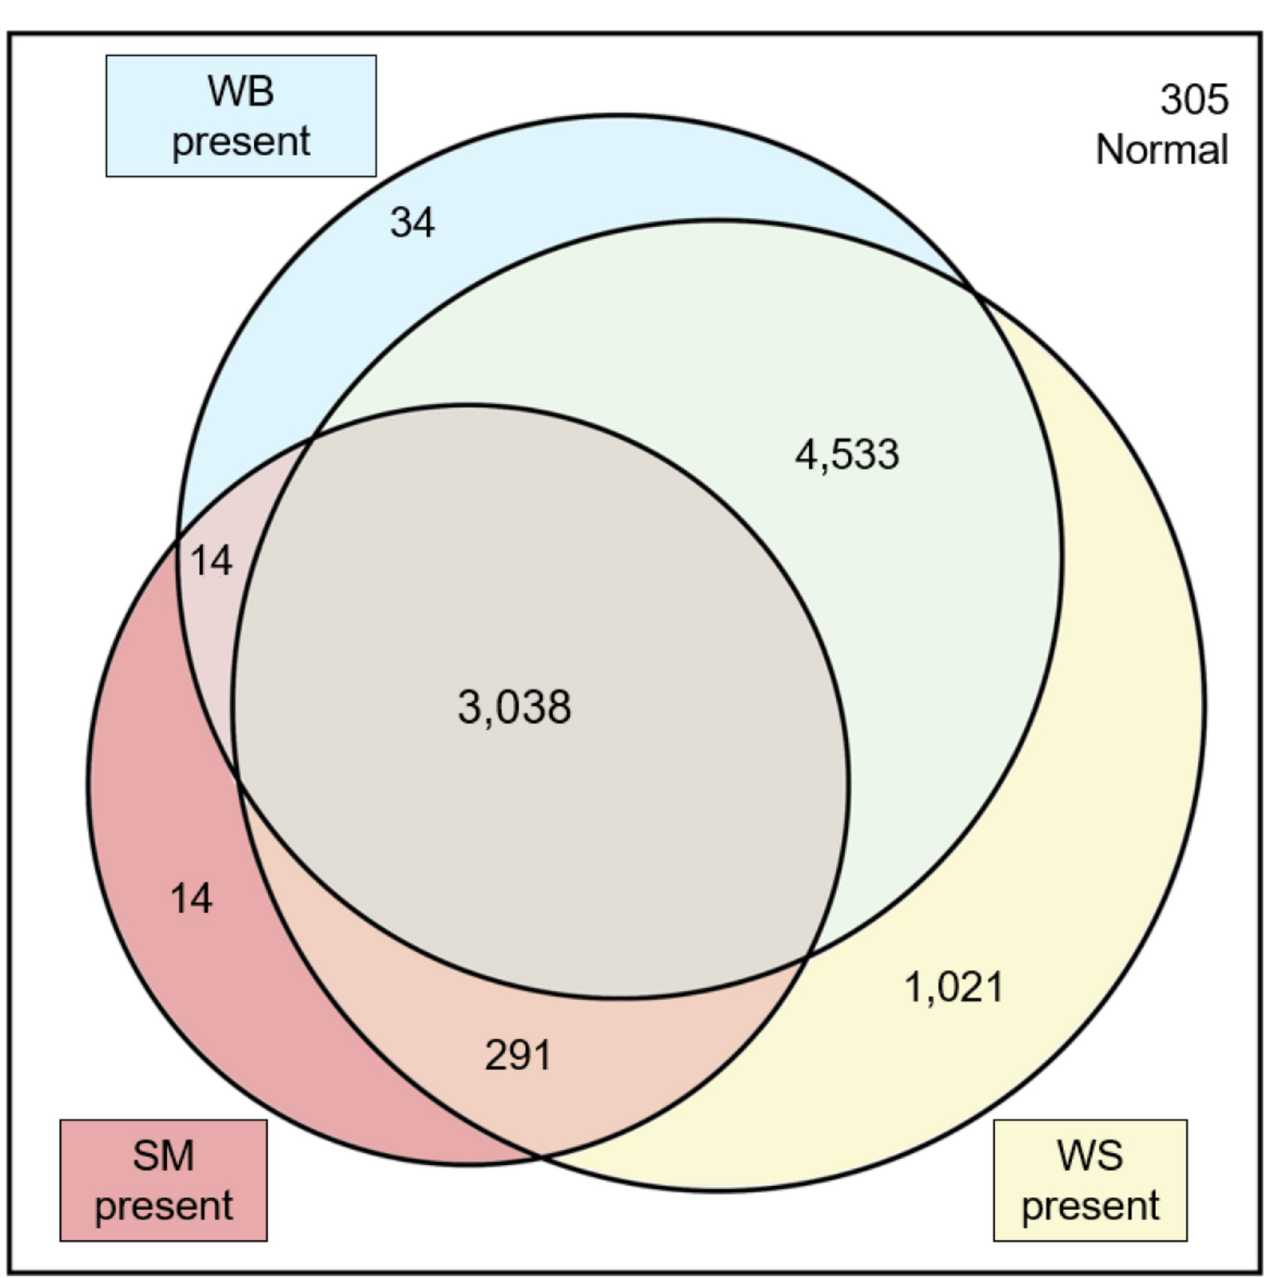
Fig 2. Venn diagram illustrating the incidence counts of spaghetti meat (SM), woody breast (WB), and white striping (WS) in 9,250 fillets. A total of 7,876 fillets presented multiple myopathies together. Within 7,876 fillets, 3,038 fillets presented SM and WB and WS together. Out of 9,250 scored fillets, only 305 fillets did not show myopathies. SM0: SM absent, SM1: SM present. WB0: WB absent, WB1: WB moderate, WB2: WB severe. WS0: WS absent, WS1: WS mild, WS2: WS moderate.